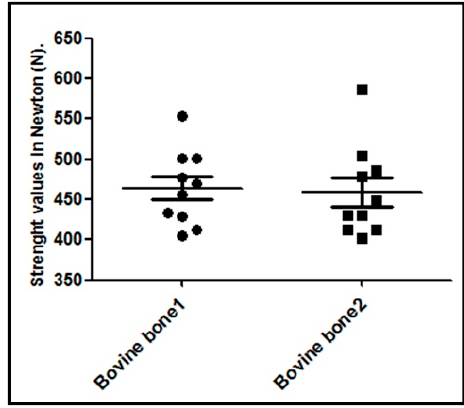
Figure 7. Graph of the compressive force values, standard deviation, and median of the measures for each sample block of both the proposed groups.